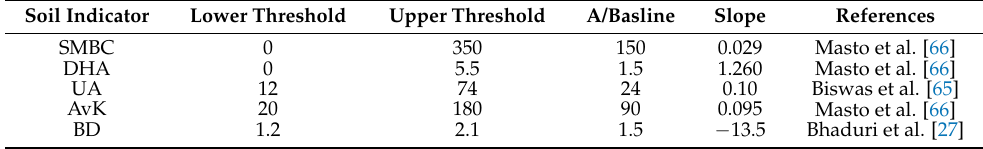
Table 7. Scoring functions (SF), threshold values, and weight for the MDS indicators. Soil